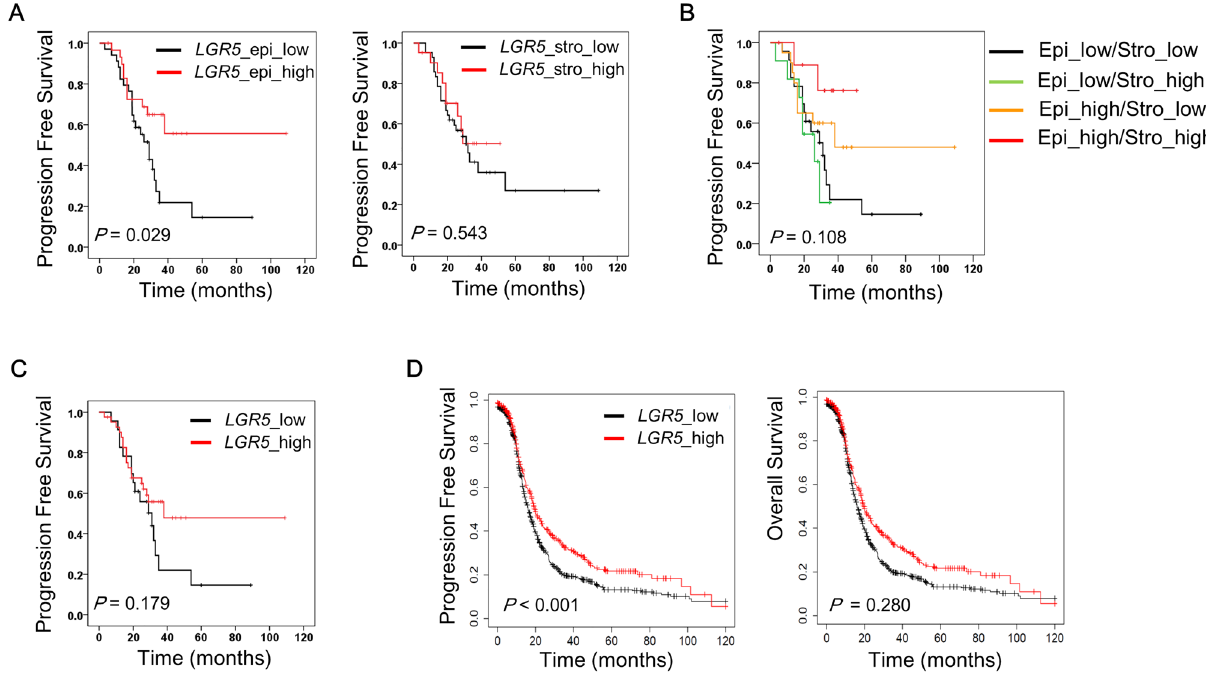
Figure 6. Prognostic value of LGR5 expression in ovarian serous carcinoma patients. LGR5 expression was classified into low and high according to the histo-scores of LGR5 (cutoff value: 40) in carcinoma cells or stromal cells in HGSC. (n = 64) ( A ) High LGR5 expression in carcinoma cells is significantly associated with better progression free survival (PFS) in HGSC patients, whereas stromal LGR5 expression is not associated with PFS. ( B ) Progression free survival with respect to epithelial and stromal LGR5 expression. ( C ) Progression free survival in global LGR5- low and-high groups. ( D ) An independent survival analysis was performed using Kaplan–Meier plotter, an online database, on ovarian serous carcinoma patients (Affy ID: 213880_at, follow up: 120 months, n = 1104). The optimal cutoff value for low- and high-LGR5 expression was automatically selected. LGR5 -high serous carcinomas had better PFS rates ( P < 0.001, hazard ratio: 0.76). However, LGR5 expression had no impact on OS.